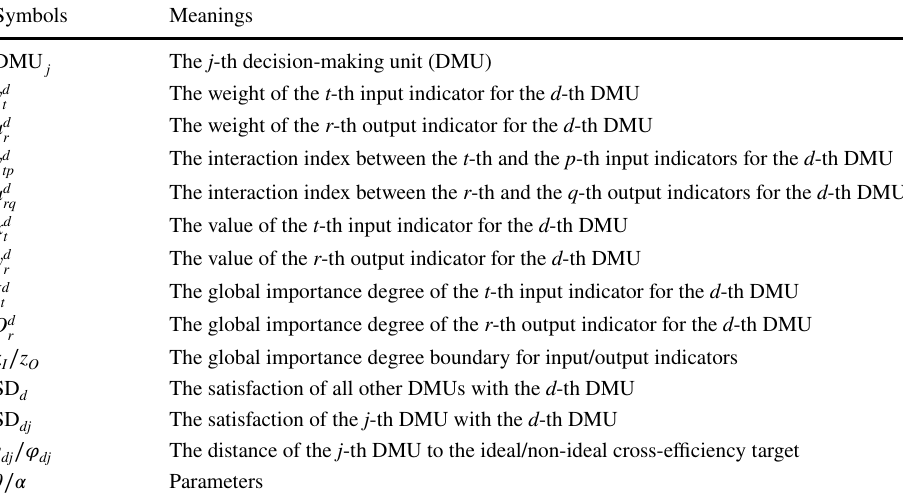
Table 1 Symbols and meanings